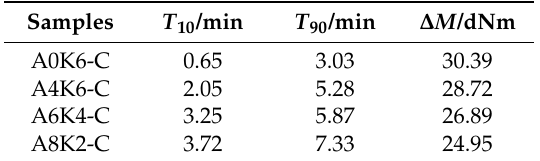
Table 6. Vulcanization characteristics of four kinds of silica/NR compounds.